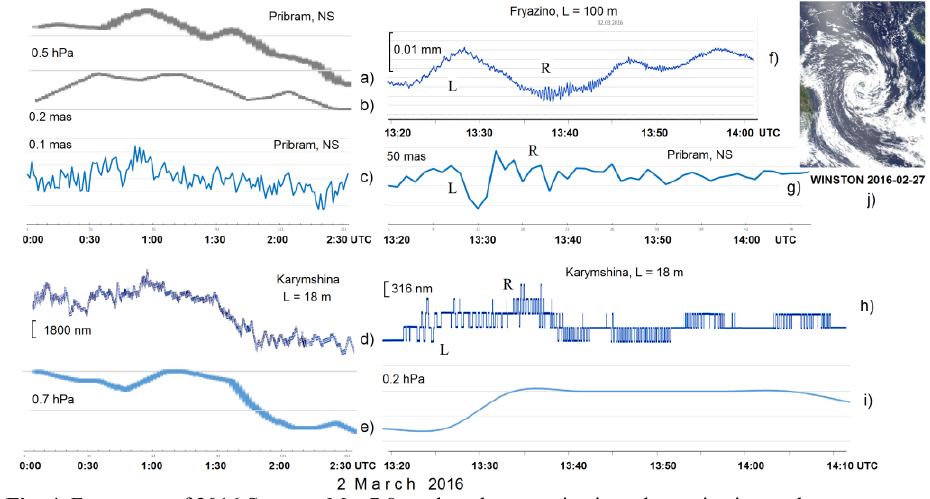
Fig. 4. Fragments of 2016 Sumatra Mw 7.8 earthquake pre-seismic and co-seismic synchronous registration at three observational point. Registration pre-seismic : PRB pressure (a), PRB tilts (b, c), KRM strains (d) and KRM pressure (e); co-seismic : FRZ strains (f), PRB tilts (g) , KRM strains (h) and KRM pressure (i); Tropical cyclone WINSTON in South Pacific – Australian region